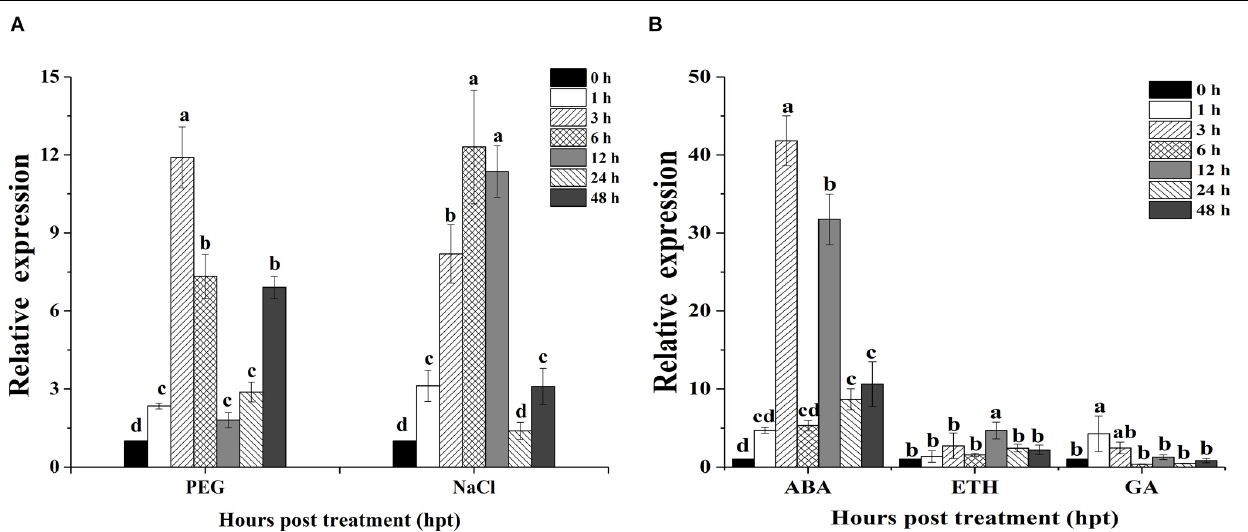
FIGURE 3 | Expression patterns of OoNAC72 in response to stress treatments. (A) Expression patterns under abiotic treatments: 20% PEG and NaCl. (B) Expression patterns under exogenous hormone treatments: ABA, ETH and GA. Three-week-old seedlings were exposed to stresses as described in section Materials and Methods. The 2 − (cid:49)(cid:49) ct method was used to measure the relative expression levels of the target genes in stressed and non-stressed leaves. Means are generated from three independent measurements; Error bars indicate SD, and Different letters on the histograms indicate significantly different values ( ∗ P < 0.05; ∗∗ P < 0.01 by Duncan’s test) compared to the non-treatment